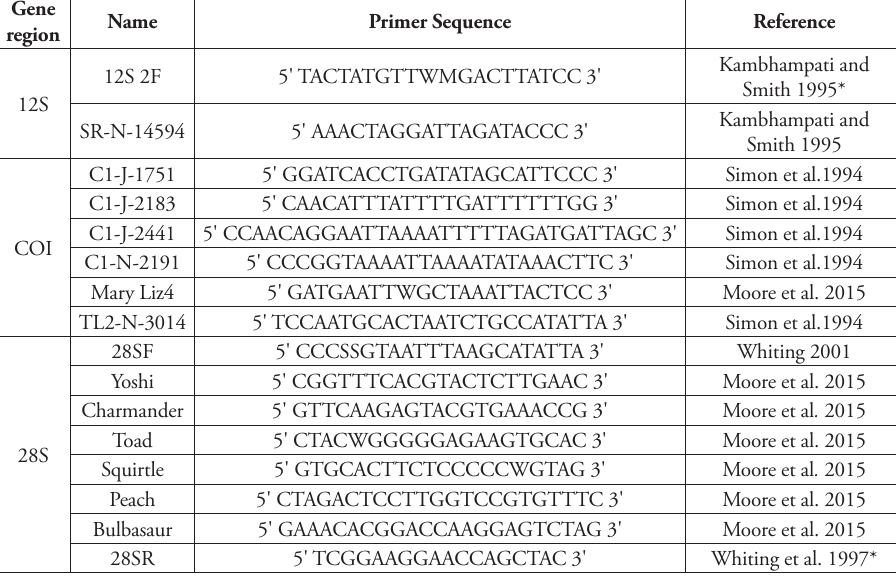
Table 1. Primers used in this study. Asterisk indicates that primers were slightly modified. Gene Name Primer region